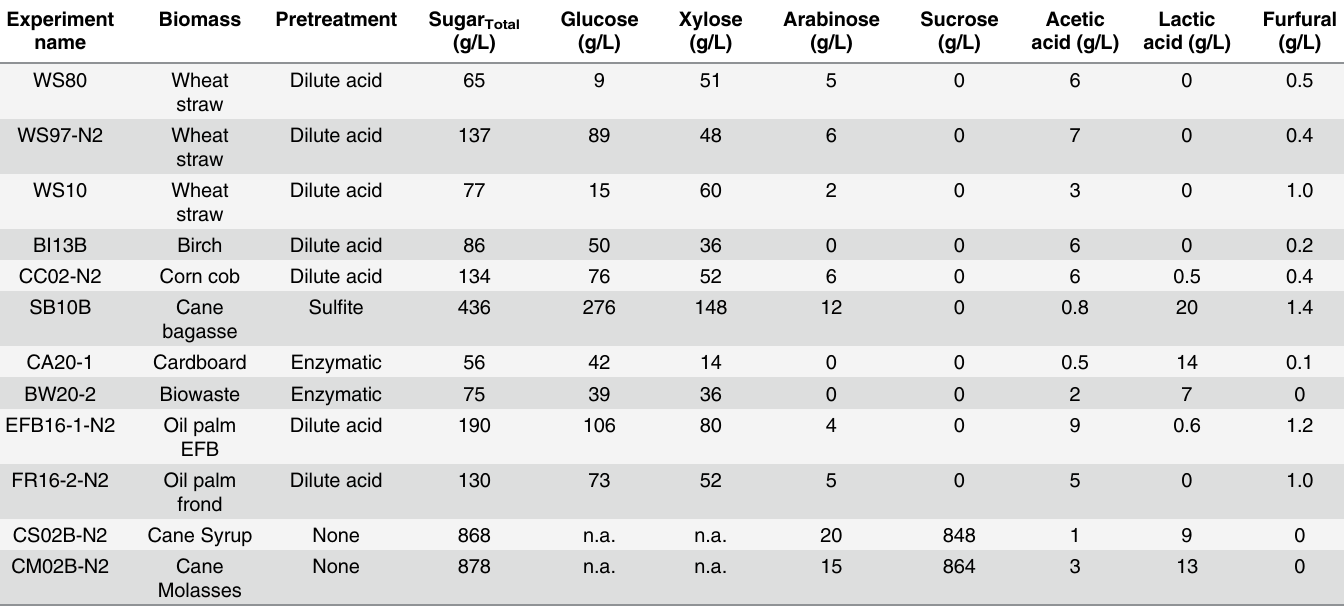
Table 1. Composition of undiluted, pretreated biomasses used for fermentation influents. Experiment